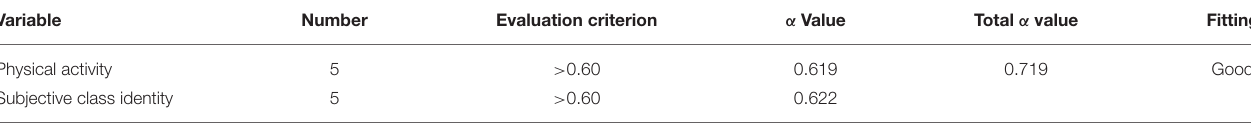
TABLE 1 | Reliability test.